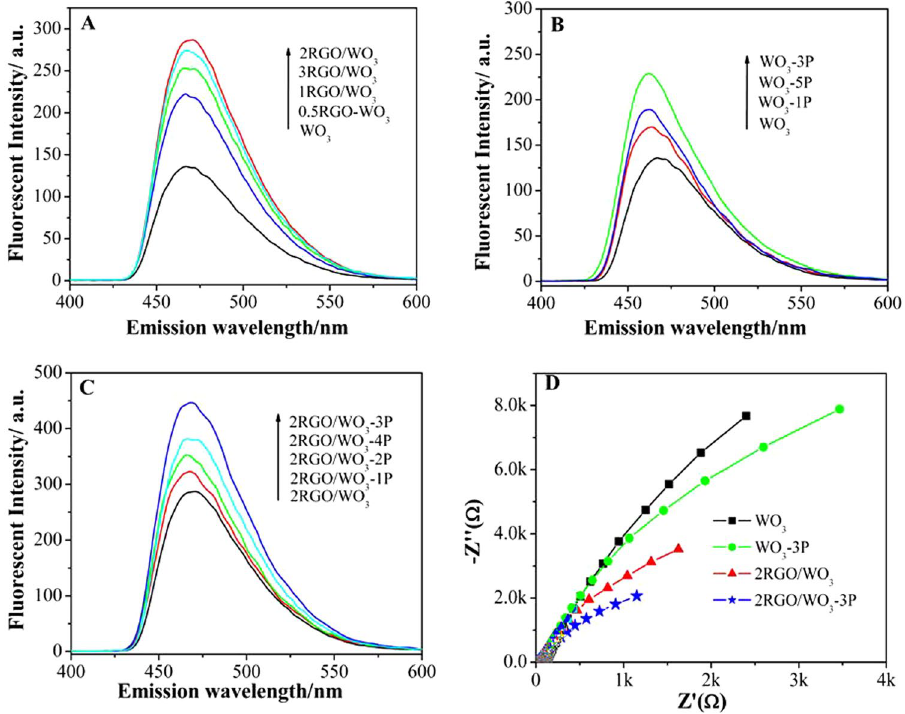
Figure 5. Fluorescent spectra related to the formed hydroxyl radical amount of WO 3 , xRGO/WO 3 ( A ), WO 3 -yP ( B ), 2RGO/WO 3 -yP ( C ), and electrochemical impedance spectra of WO 3 , WO 3 -3P, 2RGO/WO 3 and 2RGO/ WO 3 -3P ( D